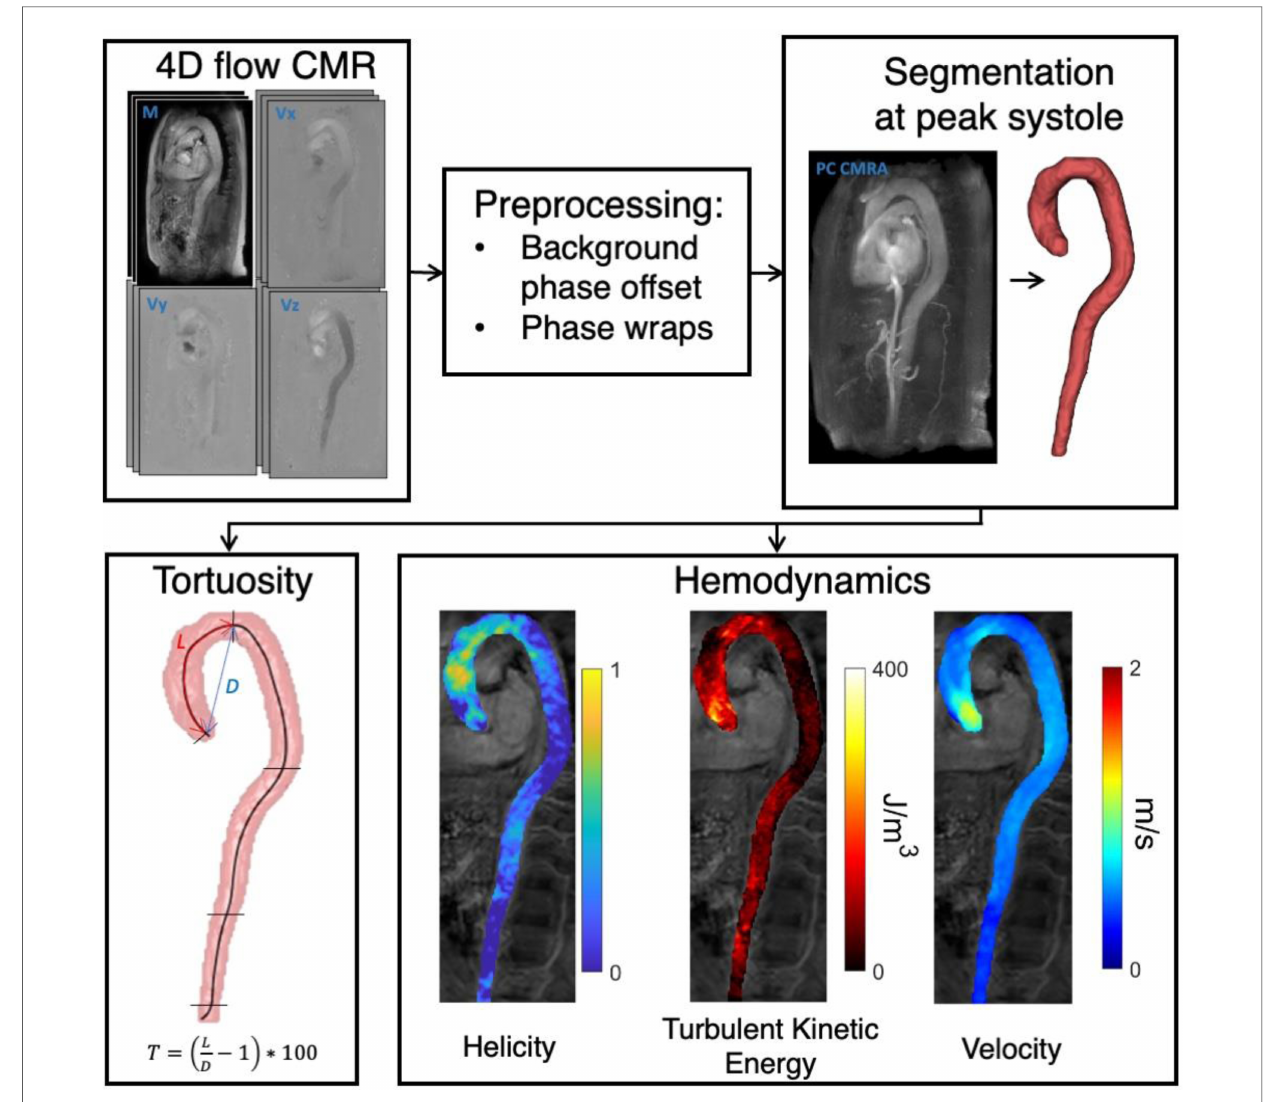
FIGURE 1 Methods work fl ow. After preprocessing of 4D fl ow MRI images, the whole aorta was segmented in PC MRI angiography images. Subsequently, tortuosity ( T ) and the hemodynamic parameters helicity, turbulent kinetic energy, and velocity were